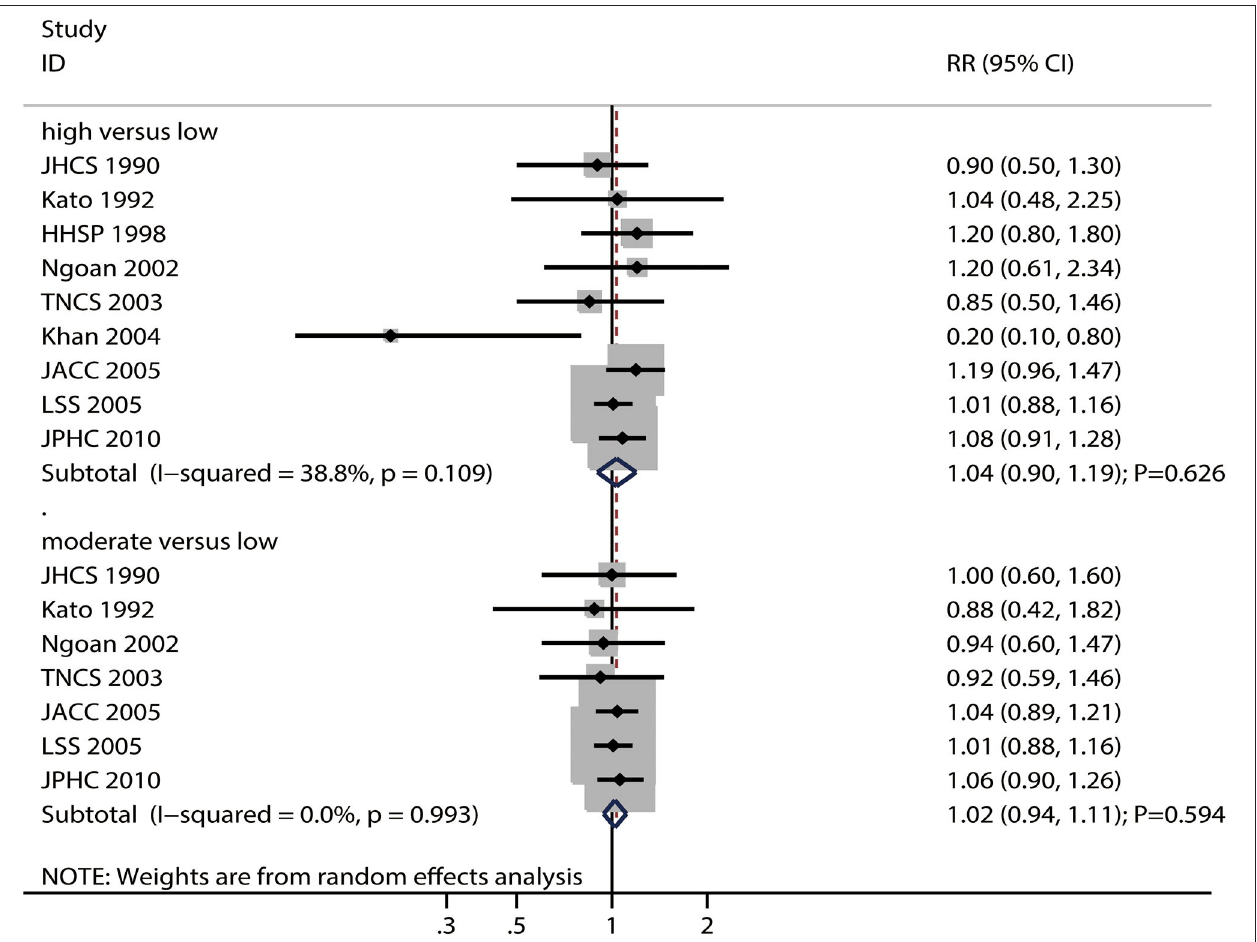
FIGURE 6 | Association between high or moderate miso-soup intake and subsequent gastric cancer